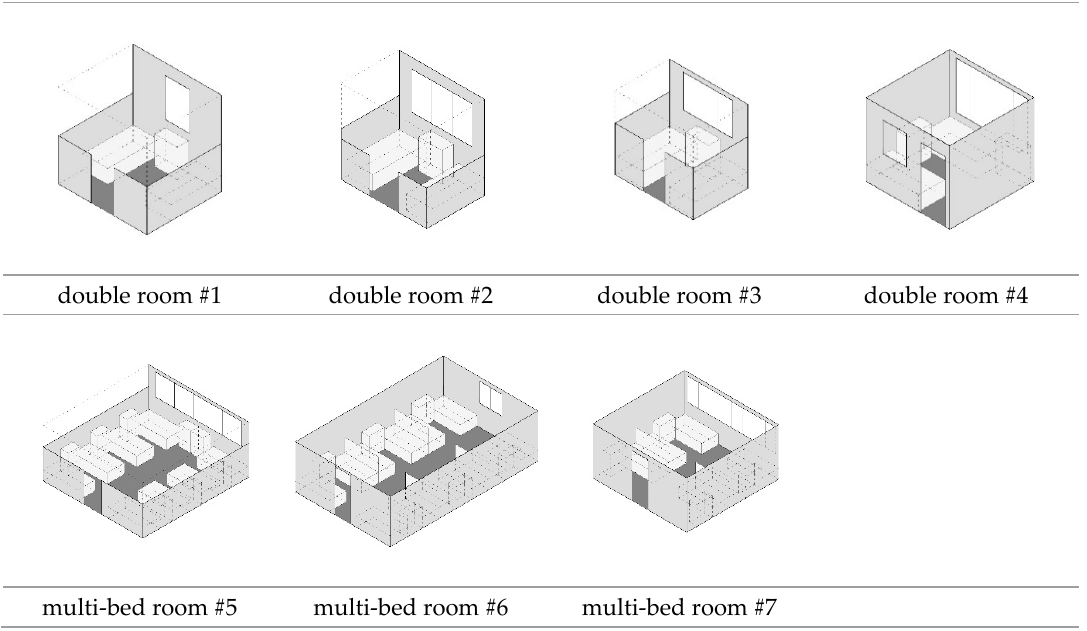
Figure 5. Axonometric view of the bedrooms (drawn by the authors).